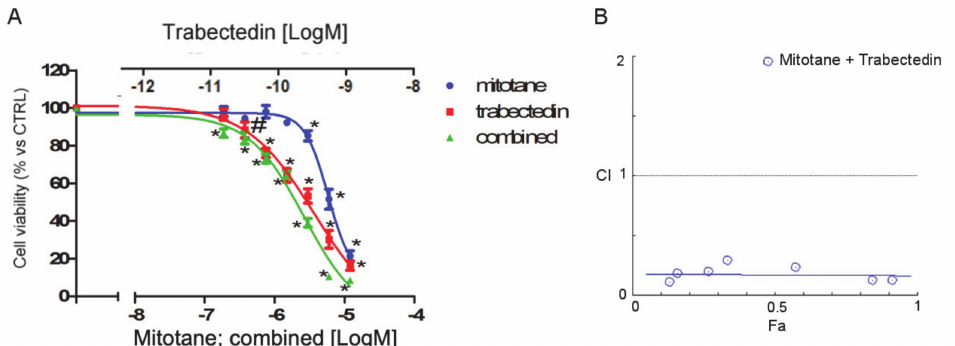
Figure 3. E ff ect of the trabectedin / mitotane combination on NCI-H295R cell viability. Cells were